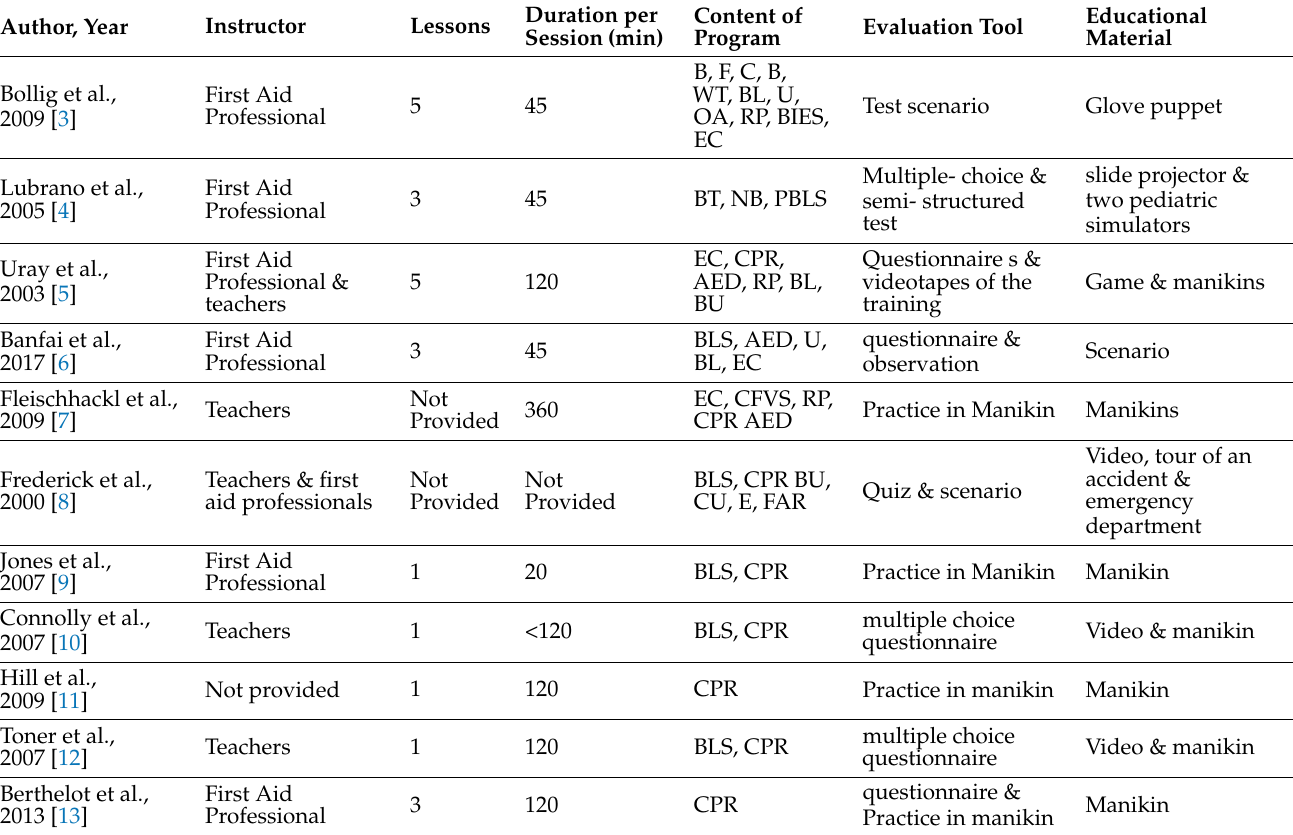
Table 2. Educational